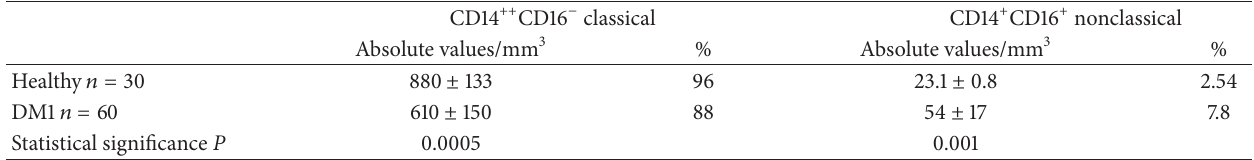
Table 1: Monocyte subsets in diabetes mellitus type 1 patients and healthy group.